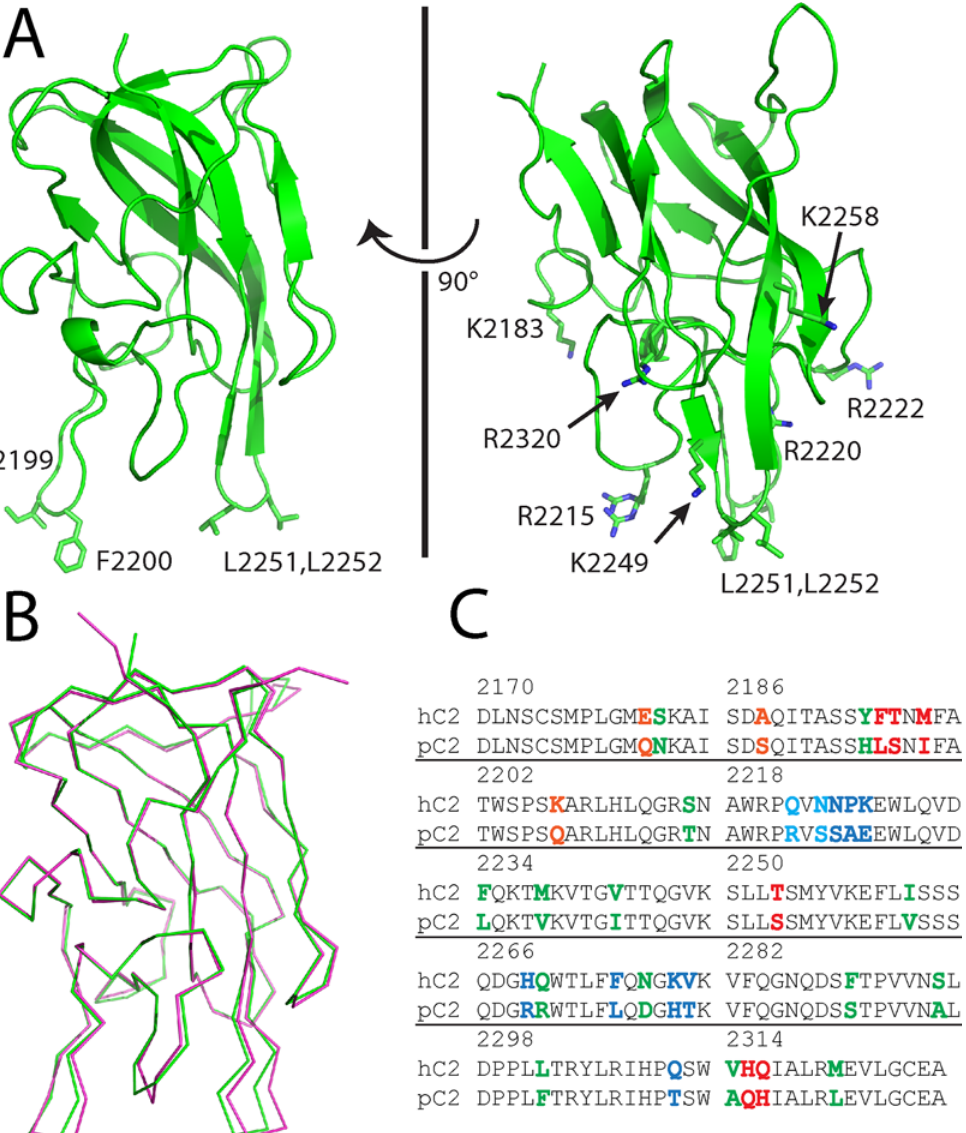
Fig 2. X-ray crystal structure of the porcine factor VIII C2 domain. (A) Ribbon diagram presentation of the 1.7 Å X-ray crystal structure. Displayed residues are solvent-exposed hydrophobic and basic residues proposed to interact with platelet surfaces. (B) Superposition of the human (pdb#: 1D7P, magenta) and porcine (pdb#: 4MO3, green) factor VIII C2 domain X-ray crystal structures. (3) Sequence alignment of human and porcine factor VIII C2 domains. Highlighted residues represent sequence differences (orange: 3E6 mAb binding region, blue: G99 mAb binding region, red: BO2C11 mAb binding region, cyan: G99 and BO2C11 binding